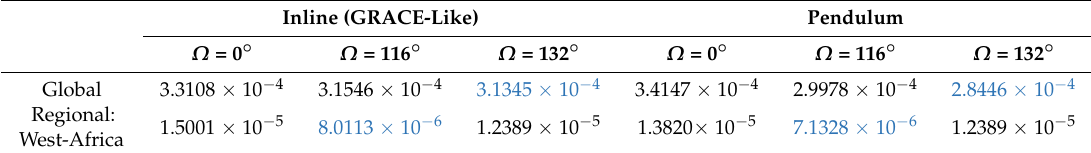
Table 3. Error RMS in terms of geoid height for global and regional (West-Africa) 6-day recovery up to L max = 32 of the scenario (a) inline and Pendulum formations. The smallest values in global and regional cases for each inline and Pendulum formation are written in blue. Inline (GRACE-Like) Pendulum